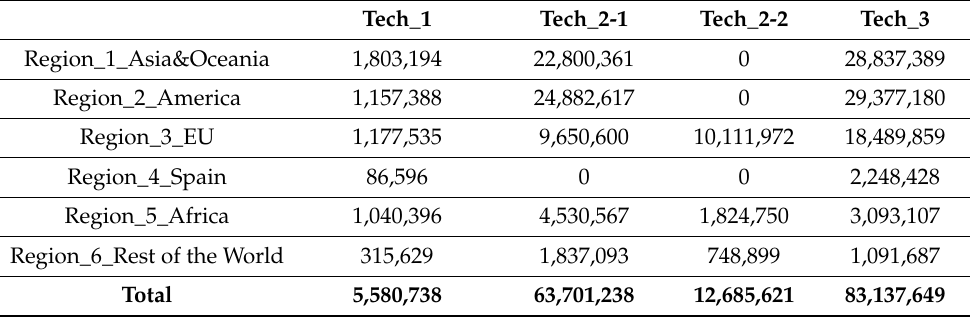
Table 11. Technology-specific factor, Solution of x by region and technology (million $).